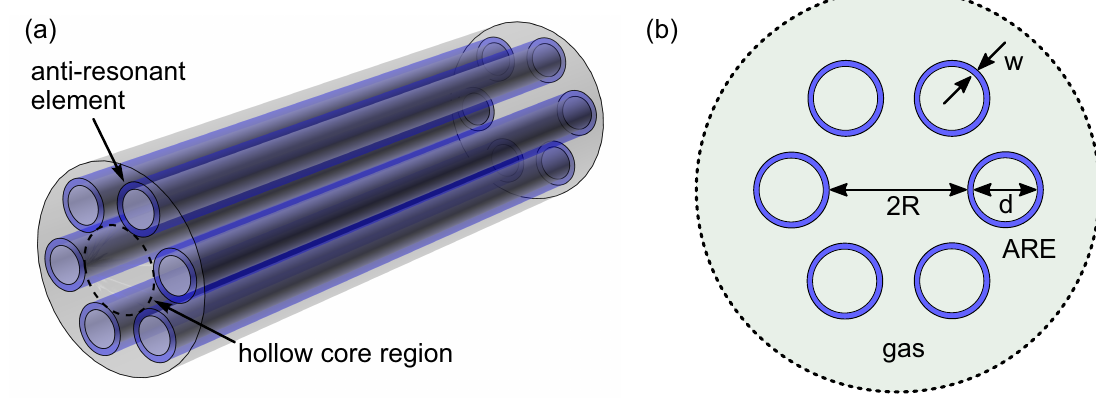
Figure 1. ( a ) illustration of the revolver-type anti-resonant hollow core fiber (RTF) geometry considered here: the fiber consists of six annulus-type anti-resonant elements (blue area) arranged around the central core region (indicted by the black dashed line); ( b ) cross section of that structure with all relevant geometric parameters. The annuluses are made from a dielectric material (typically silica glass), whereas a medium with a lower refractive index (typically gas) is located